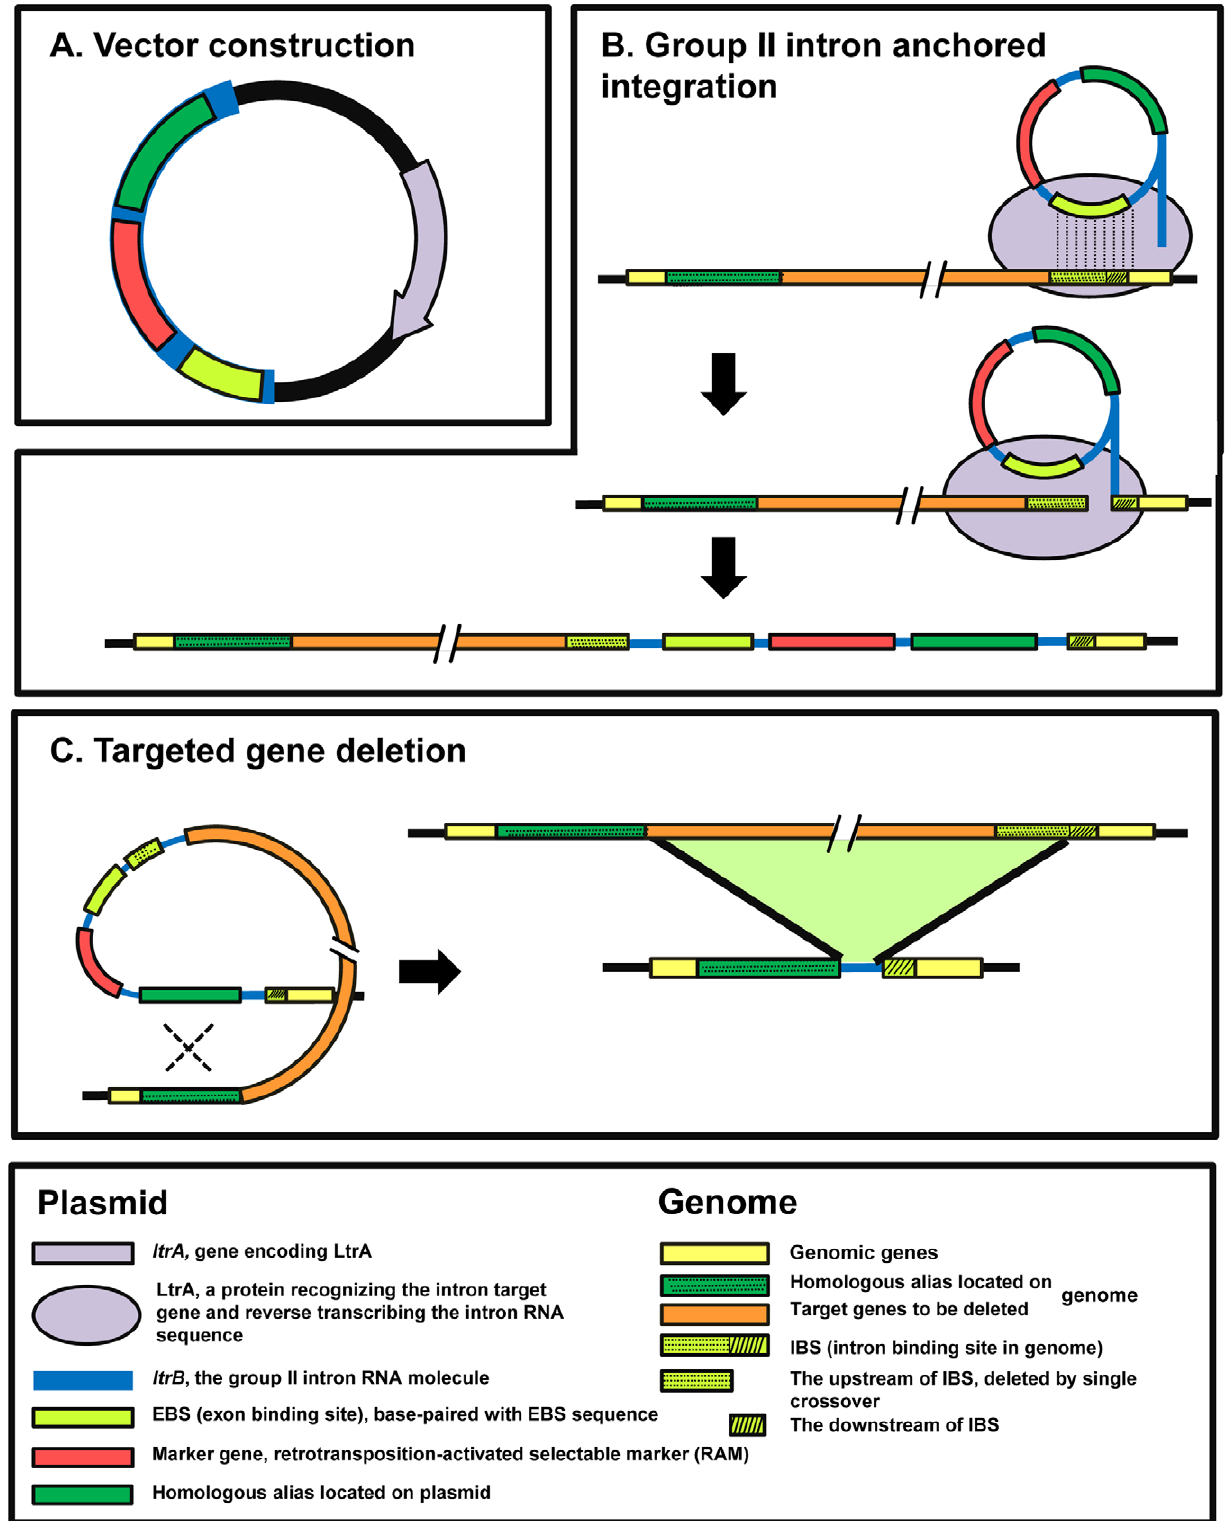
Figure 1. The strategy for target gene deletion in clostridial genome.